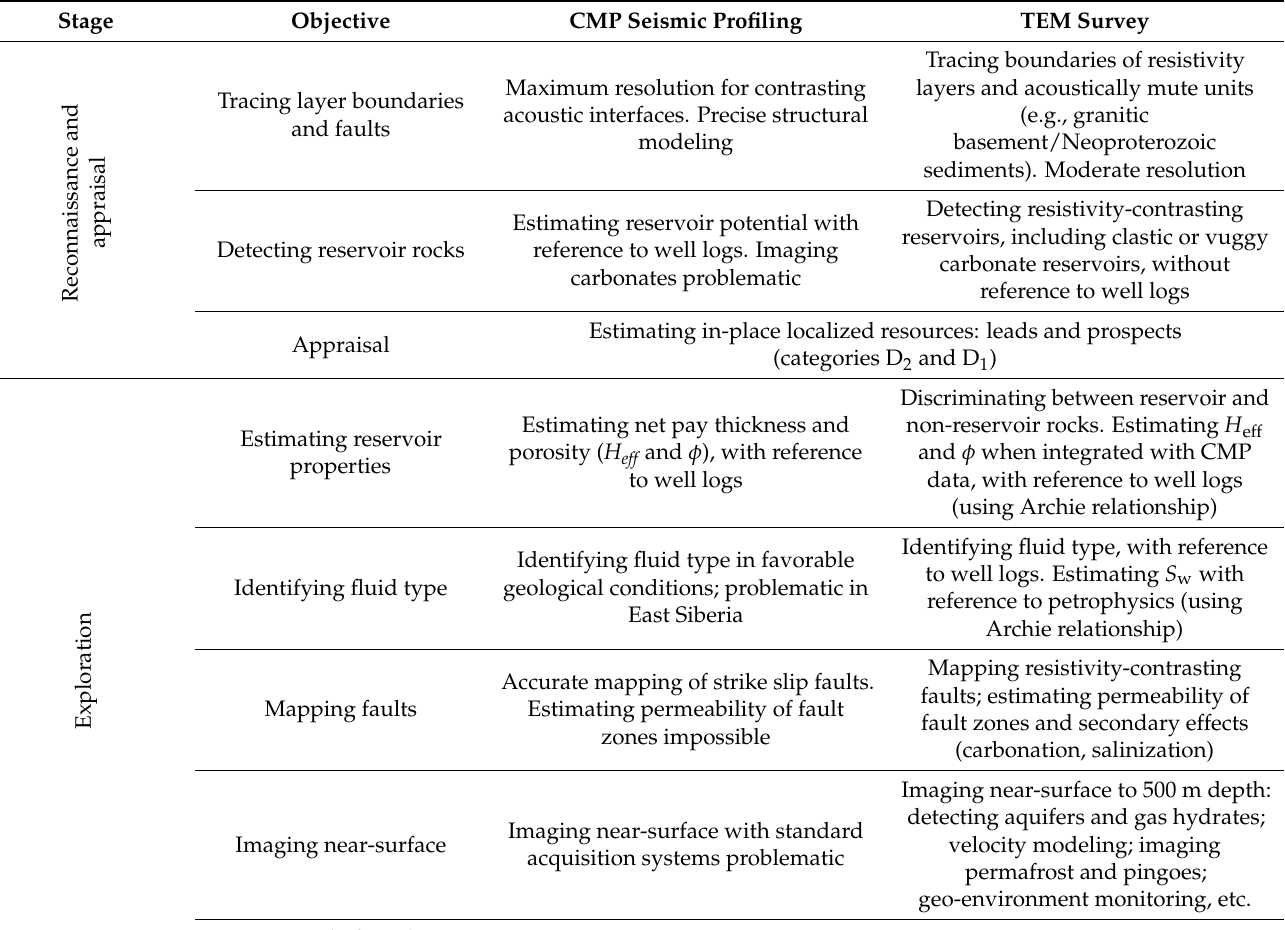
Table 2. Seismic and TEM surveys for petroleum exploration. Adapted with permission from